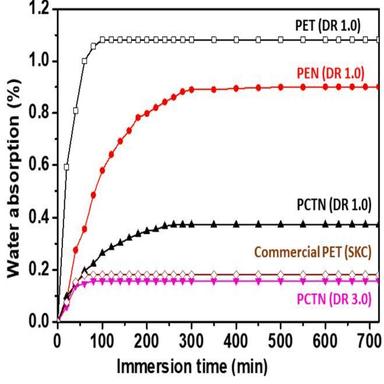
Water absorption (%) of various films fabricated in comparison with the commercial PET, and PEN homopolyester films.